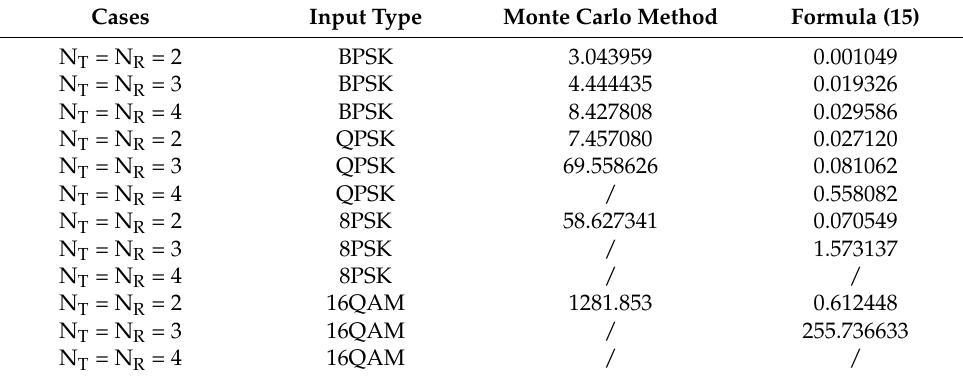
Table 1. Comparison of computational complexity between Monte Carlo method and saddle point approximation method according to the number of operations. Number of Operations Monte Carlo Method Formula (15) Exponential operation N W * (N 2 + 1) 0 Logarithm operation Table 2. Comparison of computational complexity between Monte Carlo method and saddle point approximation method according to CPU time (seconds) under different input types and correction parameters ( ρ T = ρ R = 0.4). The symbol/indicates the CPU time is more than half an hour. Cases Input Type Monte Carlo